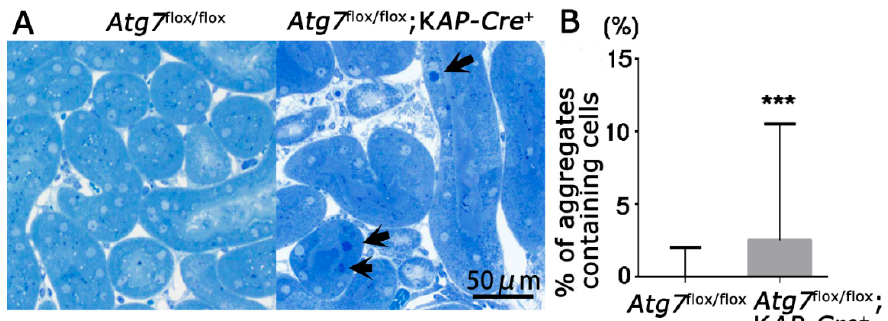
Figure 4. Accumulation of intracellular aggregates in the autophagy-deficient proximal tubular cells. ( A ) Representative images of renal proximal tubular cells in the cortico-medullary region in the kidneys from 2-month-old Atg7 flox / flox and Atg7 flox / flox ;KAP-Cre + mice. The proximal tubular cells were stained with toluidine blue. Arrows indicate representative aggregates heavily dyed with toluidine blue. ( B ) Quantification of cells with toluidine blue positive aggregates dyed with toluidine blue. In each group at least five independent images were analyzed (magnification; 200 × ). Data in the graph are expressed as the median ± range. *** p < 0.01.